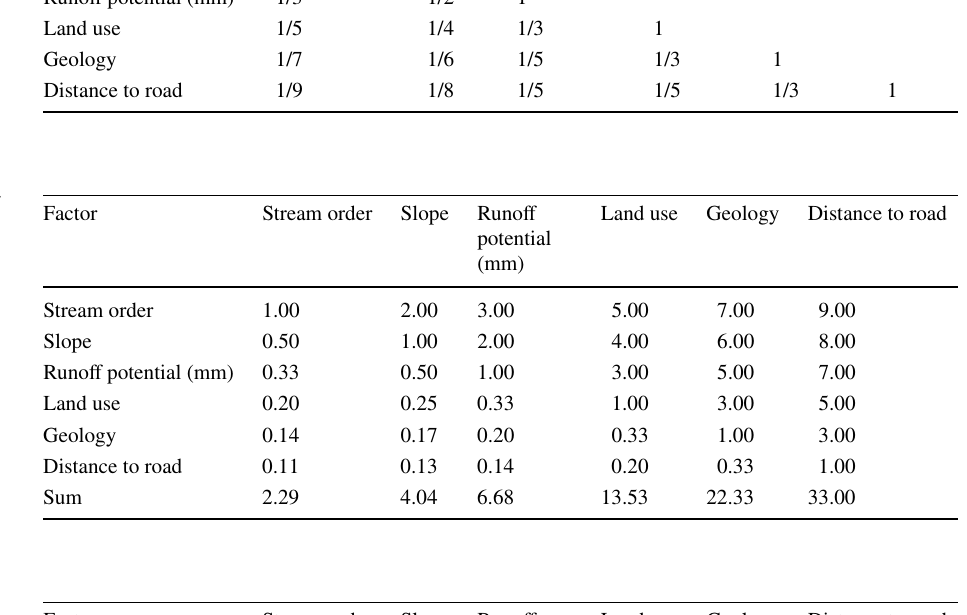
Table 7 Normalized pairwise matrix calculated